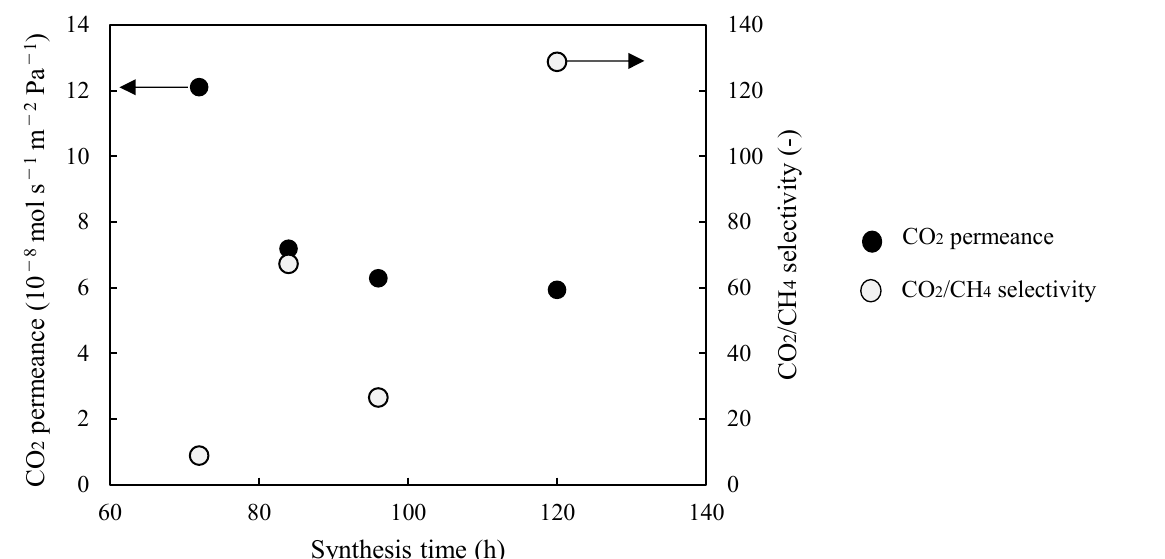
Figure 8. CO 2 permeance and CO 2 /CH 4 selectivity of Al-containing ZSM-58 membranes as functions of synthesis time. CO 2 permeance and CO 2 /CH 4 selectivity values are averaged from two samples.